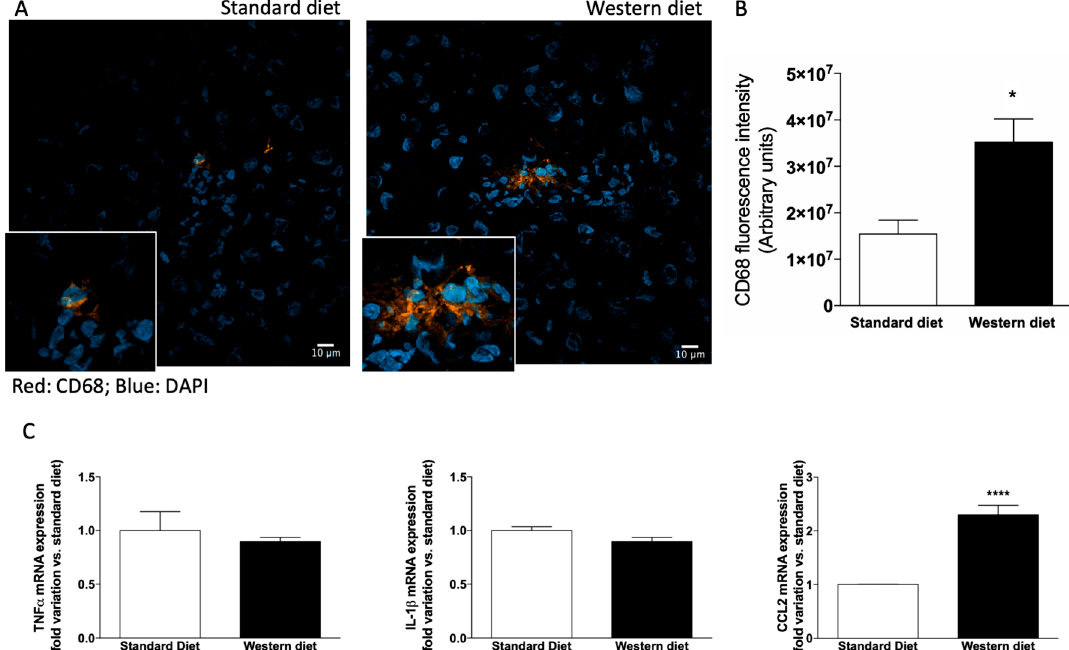
Figure 5. CD-68 positive cells in the liver. ( A ) Representative photomicrographs of liver tissue obtained from a rat fed with standard (upper panel) and Western (lower panel) diet stained with CD-68, a marker of hepatic macrophages. ( B ) Quantification of CD-68-related immunofluorescence. Values are means ± S.E.M. The histograms report the intensity of fluorescence (arbitrary units). Representative images from five independent experiments are shown. Cell nuclei are stained blue with DAPI. ( C ) mRNA expression of genes involved in the inflammatory process. * p < 0.05, **** p < 0.0001 vs. rats fed with standard diet.